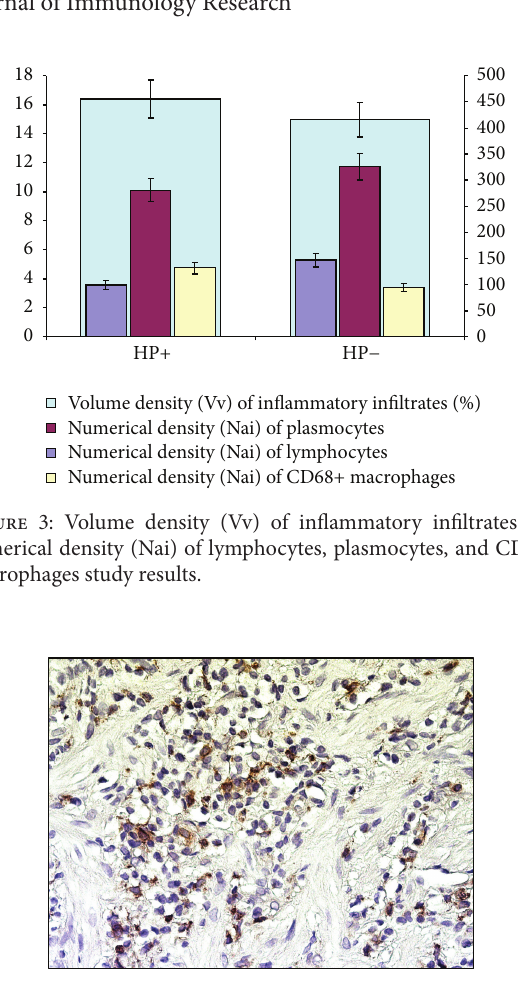
Figure 4: Antrum mucosa in H. pylori -associated gastritis: CD68+ macrophages in infiltrate of lamina propria, magnitude × 400.